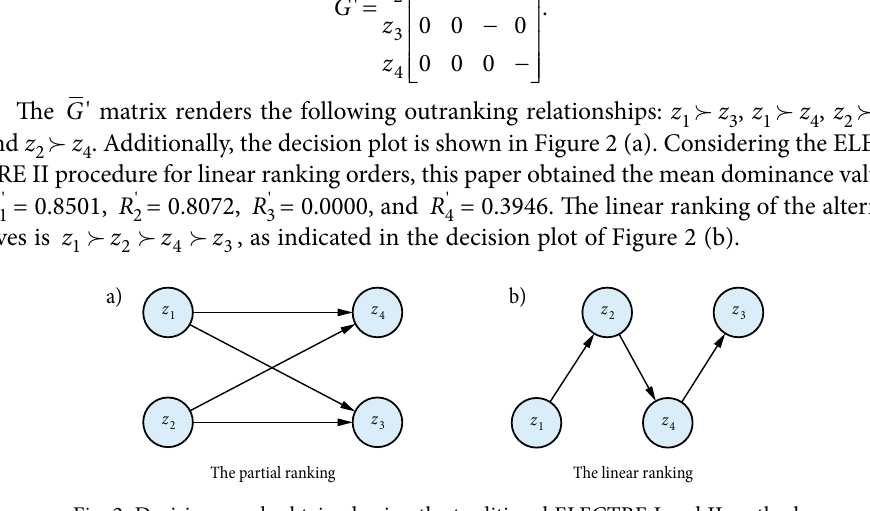
Fig. 2. Decision graph obtained using the traditional ELECTRE I and II